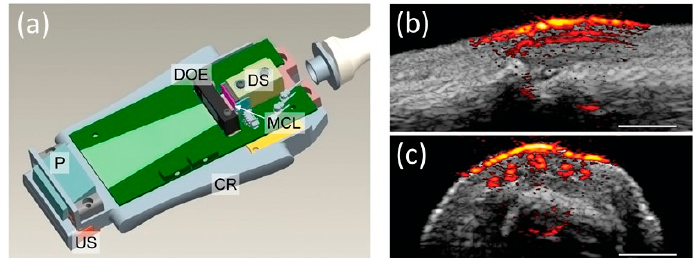
Figure 15. ( a ) A schematic of the handheld PA and US probe. US: ultrasound array transducer; P: deflecting prism; DOE: diffractive optical elements; DS: diode stack; MCL: micro-cylindrical lenses; CR: aluminum cooling rim. Photoacoustic/ultrasound images of a human proximal interphalangeal joint in the ( b ) sagittal and ( c ) transverse planes. Adapted with permission from K. Daoudi, P.J. van den Berg,